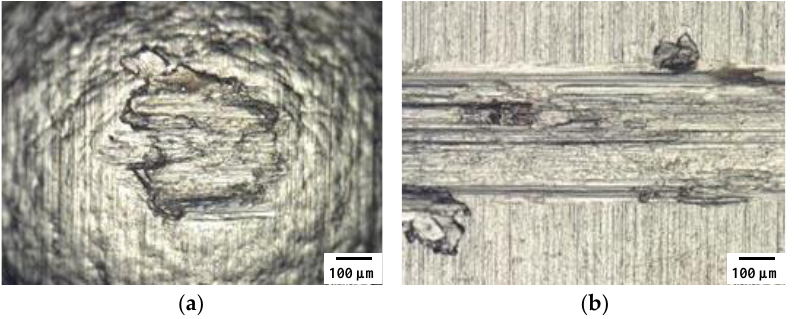
Figure 8. Micrographs of the worn surfaces of ( a ) the embossed specimen and ( b ) the plate specimen ( t = 0.64 mm, Ag plating 5 µm, v = 200 mm/min, n = 100 times).